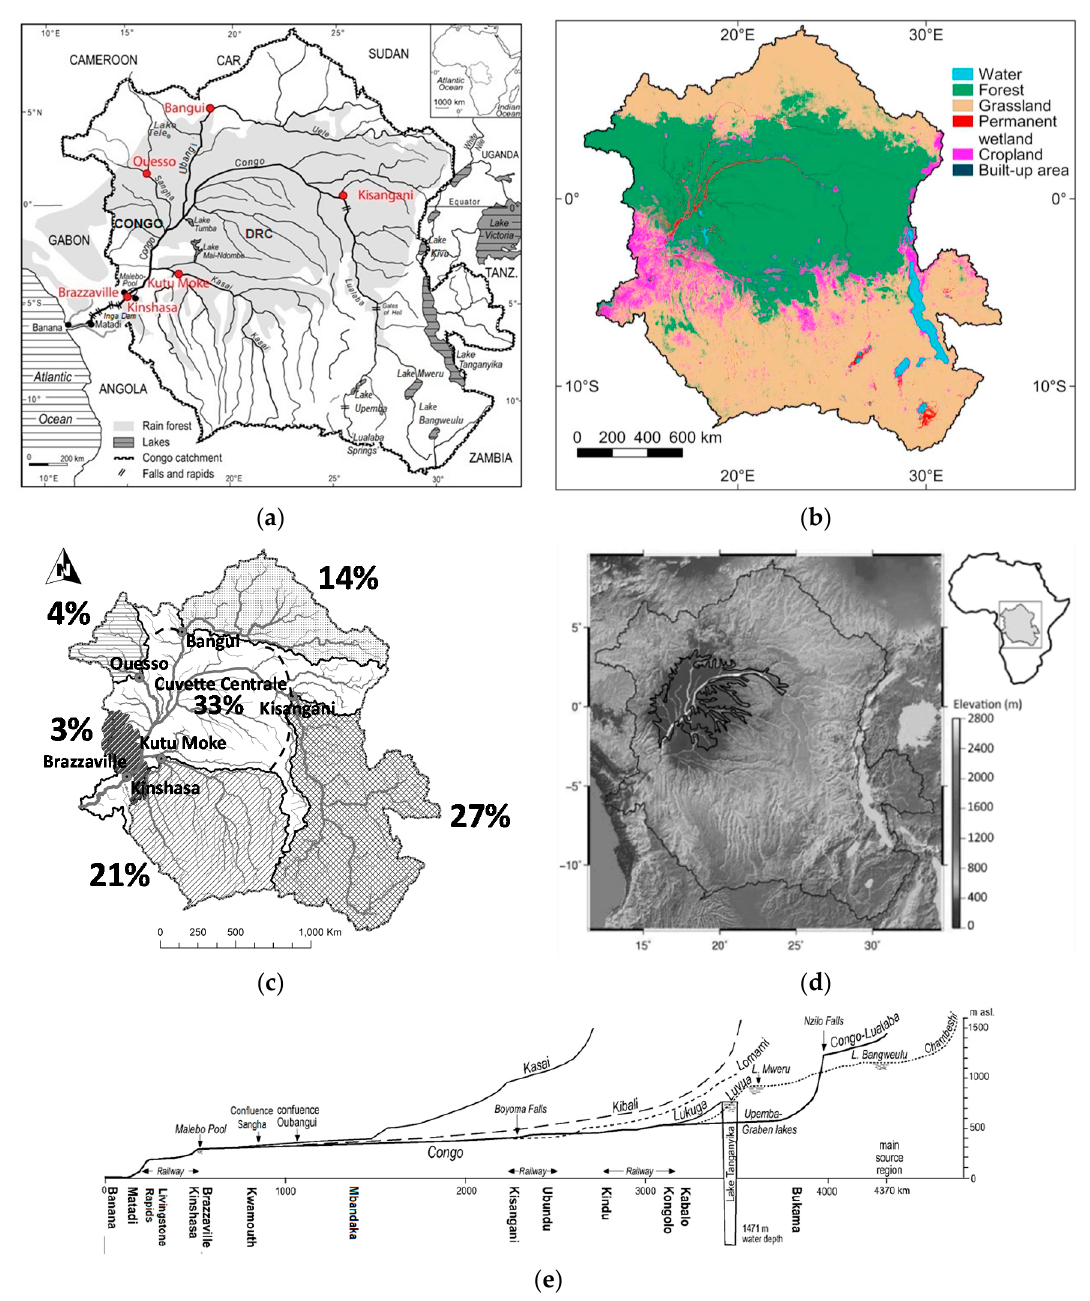
Figure 1. ( a ) Overview of Congo basin (adapted from Runge, 2007) [4], ( b ) Land cover on Congo basin [11], ( c ) Main drainage units studied in Congo basin: Lualaba at Kisangani St., Kasaï at Kutu Moke St., Sangha at Ouesso St., Ubangi at Bangui St., Batéké plateau and ‘Cuvette Centrale’, with their percentage of area of Congo basin represented by the BZV/KIN station. Legend: the dashed line encircles the general area of the ‘Cuvette Centrale’. The area with inclined dark hatching is that of the Batéké plateau, ( d ) Topography of the Congo Basin and of the flooded portion of the Central Basin. The topography comes from the SRTM [12] and the flooded portion of the Central Cuvette (the black polygon) is generalized by Bwangoy et al. (2010) [9], ( e ) Longitudinal profiles of the Congo River and its main tributaries (adapted from Runge, 2007) [4].